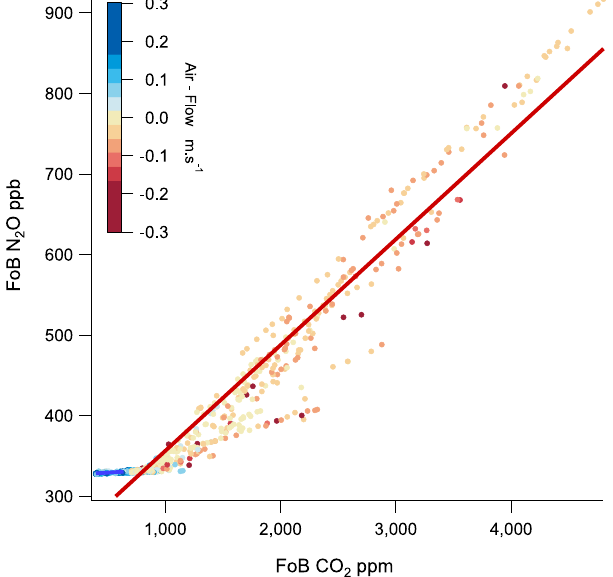
Figure 7. Correlation plot of N 2 O vs CO 2 from Flitch of Bacon (0.5 × 2.0 m passage) for two time periods; autumn 5/3/15–18/4/15, least squares line fit (red), n = 935 and winter 30/6/15–17/7/15, least squares line fit (blue), n = 358. Data points are colour coded to represent air-flow direction and velocity. Only air from above Chifley Cave (ambient + soil air, red) contains N 2 O greater than ambient, indicative of soil air. Air-flow in the opposite direction (blue) is tightly clustered around ambient composition with no addition or depletion of N 2 O within Chifley